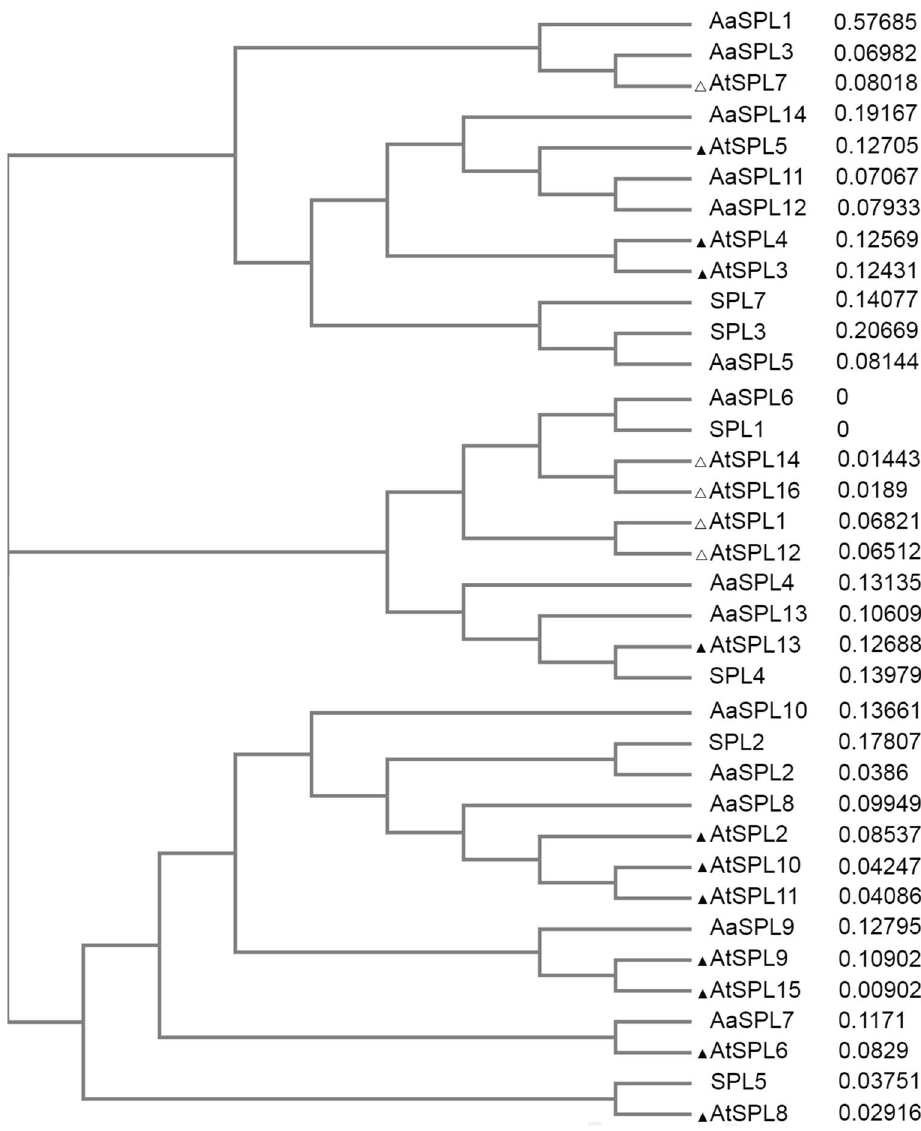
The black triangle ( ▲ ) or blank triangle ( △ ) indicates miR156 targeted or non-targeted Arabidopsis SPLs